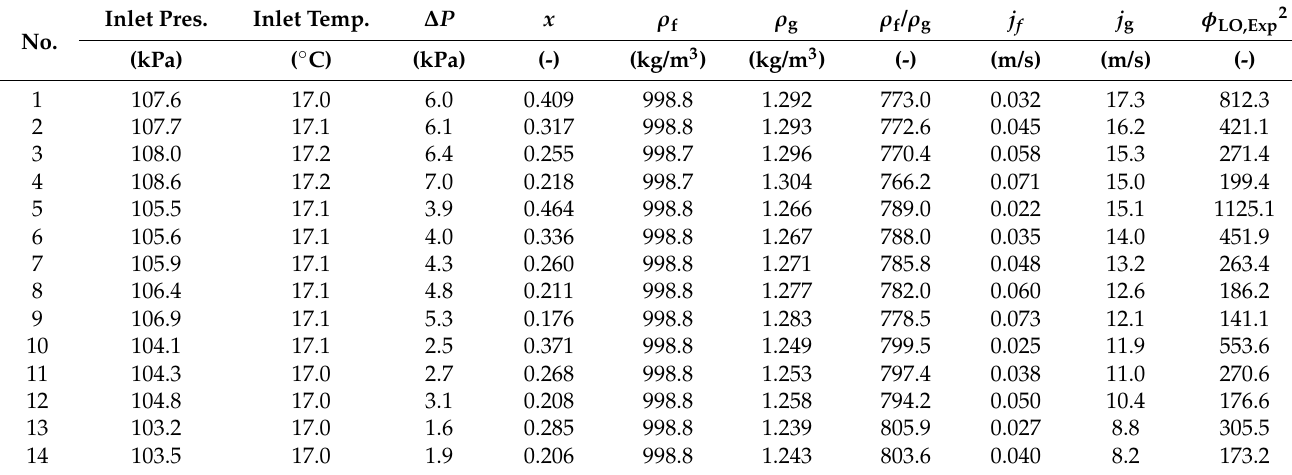
Table 6. Two-phase test results for the half-scale test